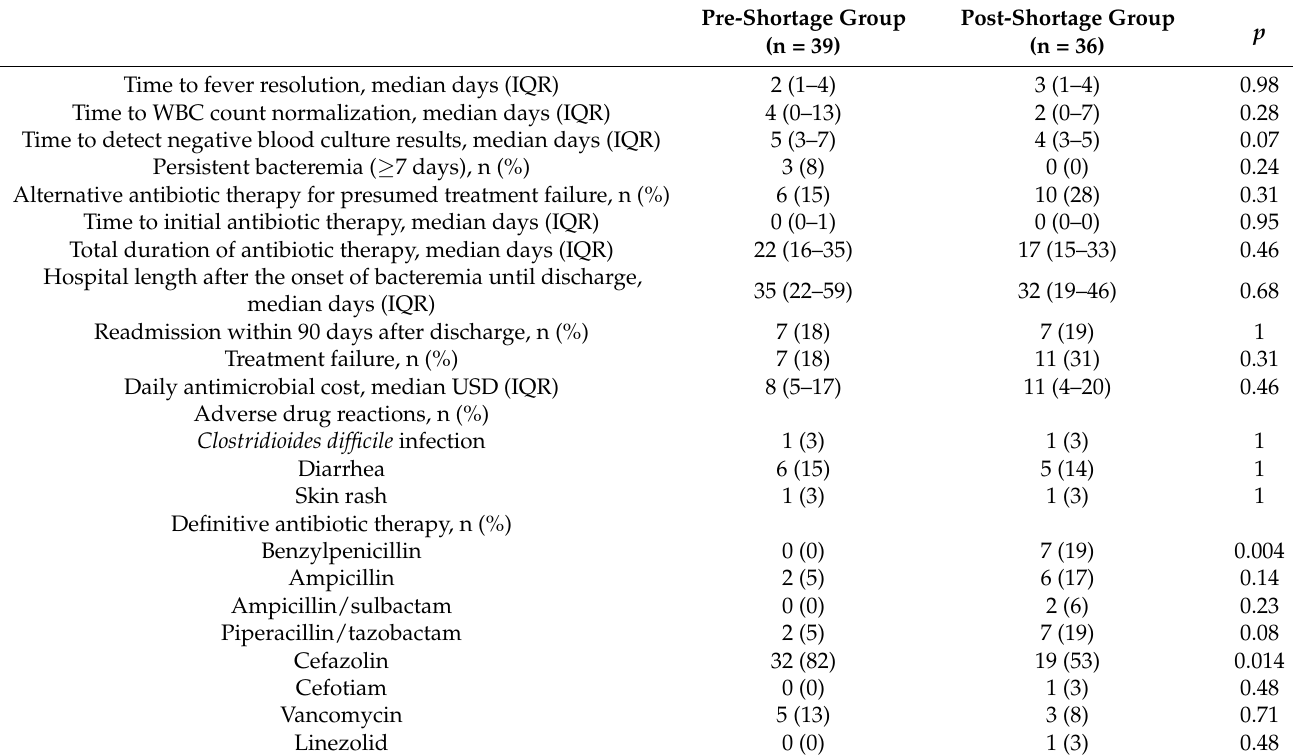
Table 2. Clinical outcomes of patients with MSSA bacteremia.